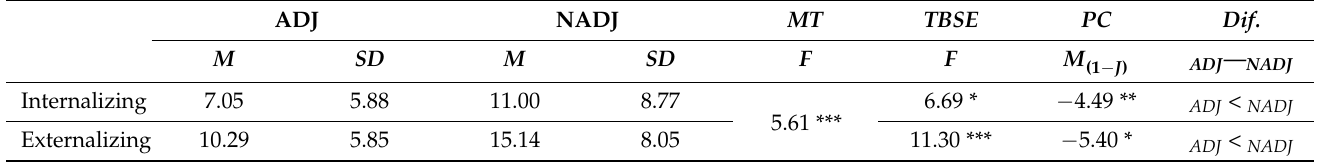
Table 5. The impact of adjusted vs. non-adjusted couple’s relationship (clusters) on toddlers’ inter- nalizing and externalizing